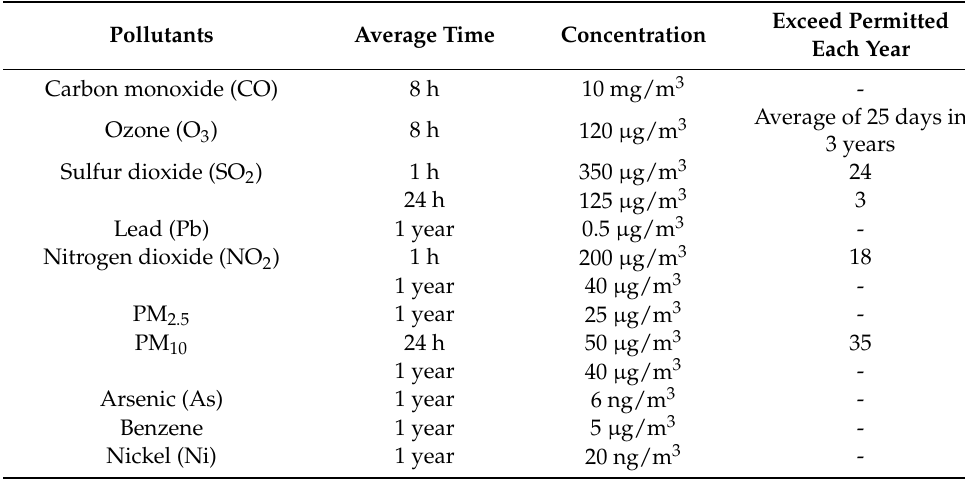
Table 5. Ambient Air Quality Standards of European Union [63].